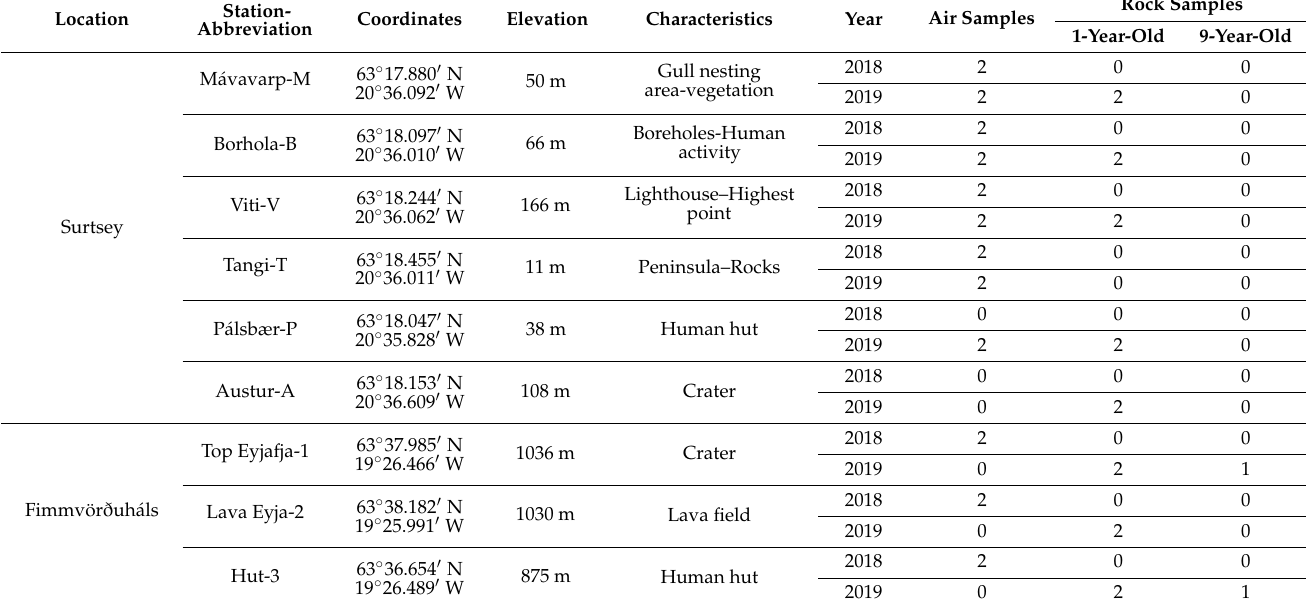
Table 1. Characteristics of the sampling stations and number of